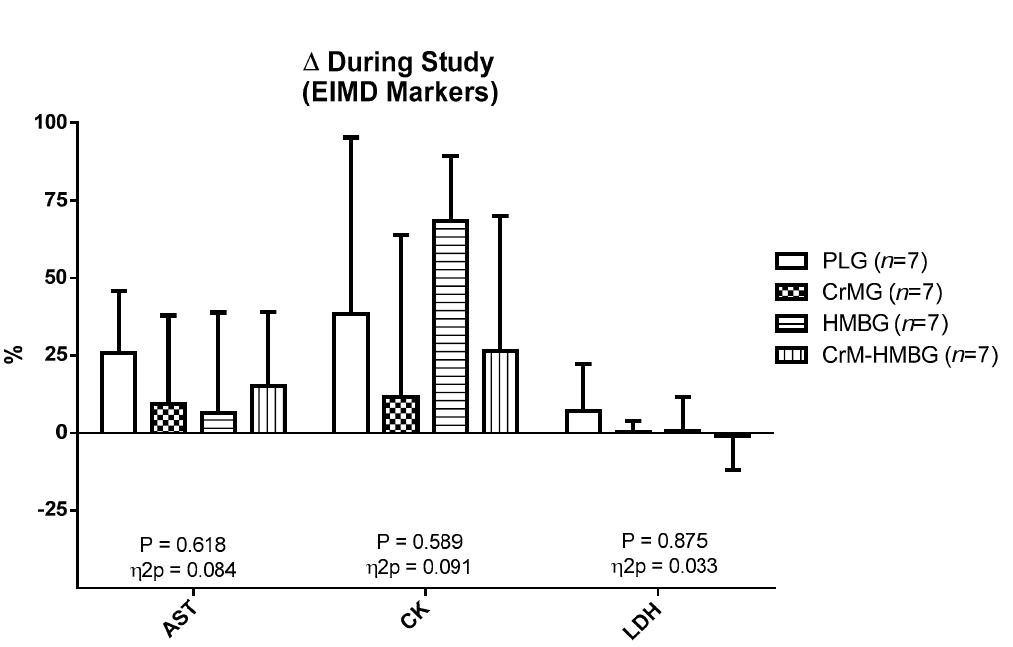
Figure 2. Percentage changes in exercise-induced muscle damage (EIMD). Data are expressed as mean ± standard error. Δ : ((T2 − T1)/T1) × 100; differences among groups in each test by ANOVA test.